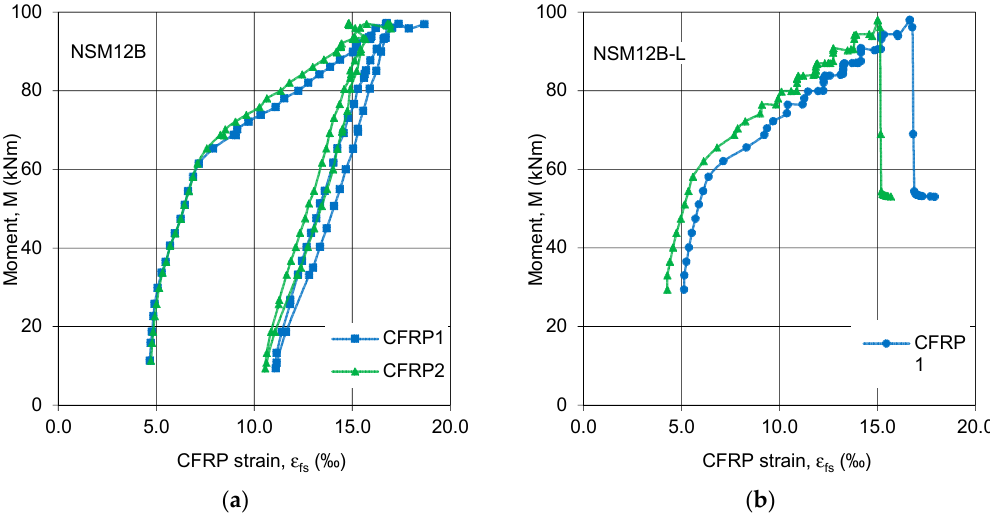
Figure 10. Bending moment vs. CFRP strain curves of series B: ( a ) NSM12B; and ( b ) NSM12B-L.